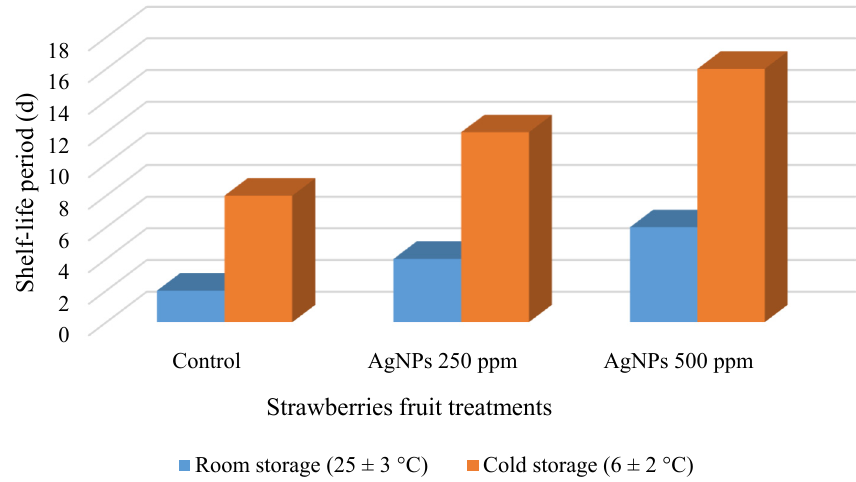
Figure 8. Shelf-life of strawberry fruit.